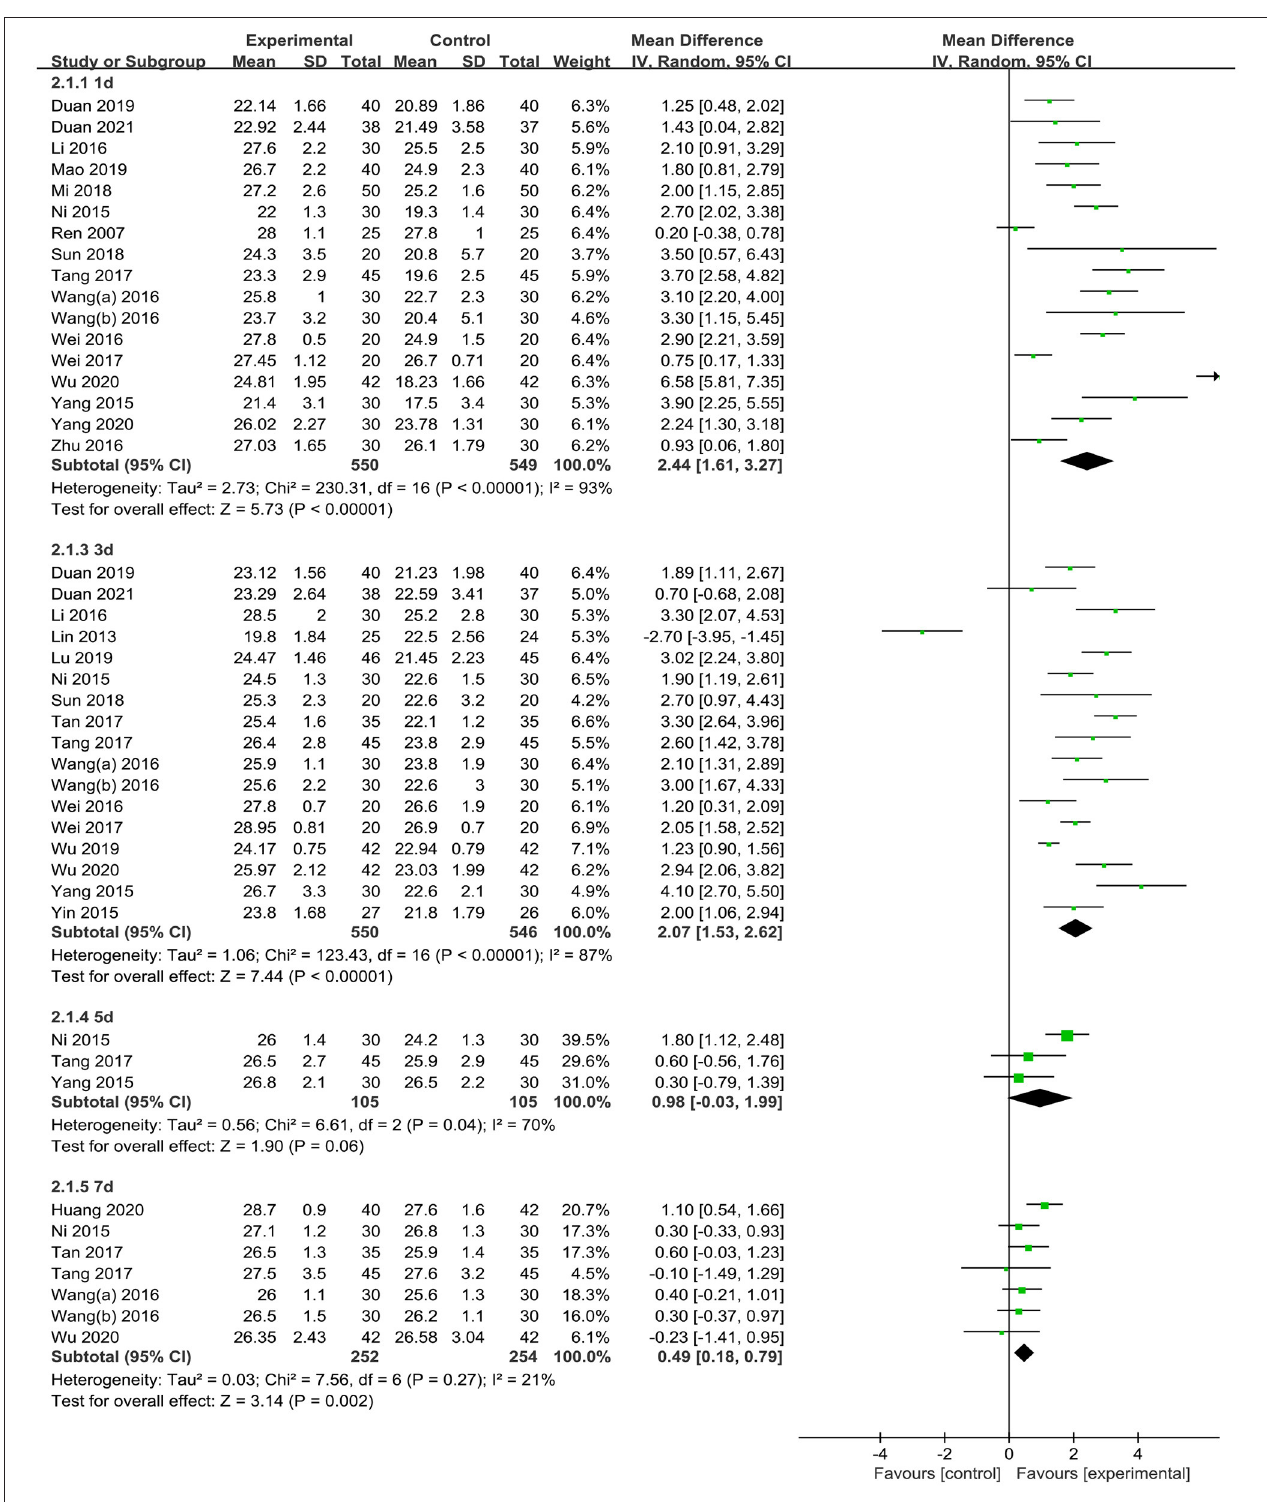
FIGURE 4 | Meta-analysis and forest plot for MMSE scores at different periods.